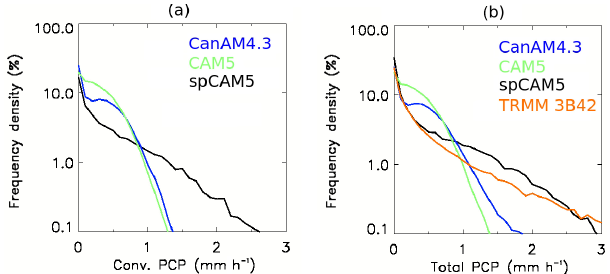
Figure 2. (a) Frequency density of 3-hourly convective precipita- tion per 0.1mmh − 1 bin, (b) frequency density of 3-hourly total precipitation per 0.1mmh − 1